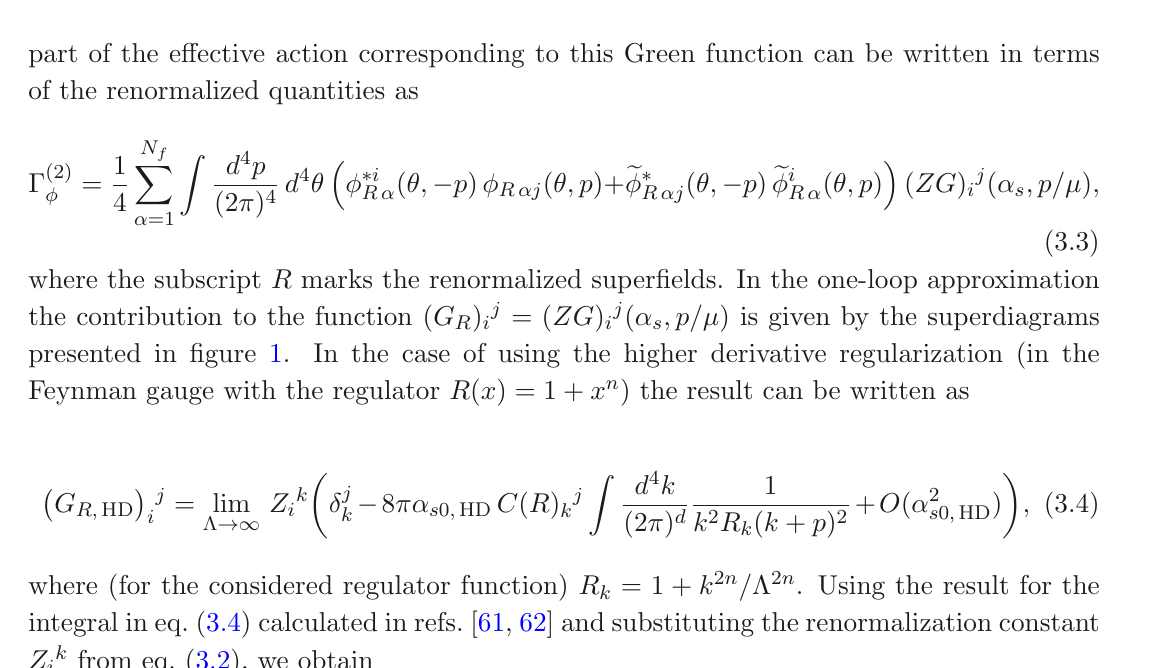
Figure 1 . The superdiagrams giving the two-point Green function of the matter superfields in the one-loop